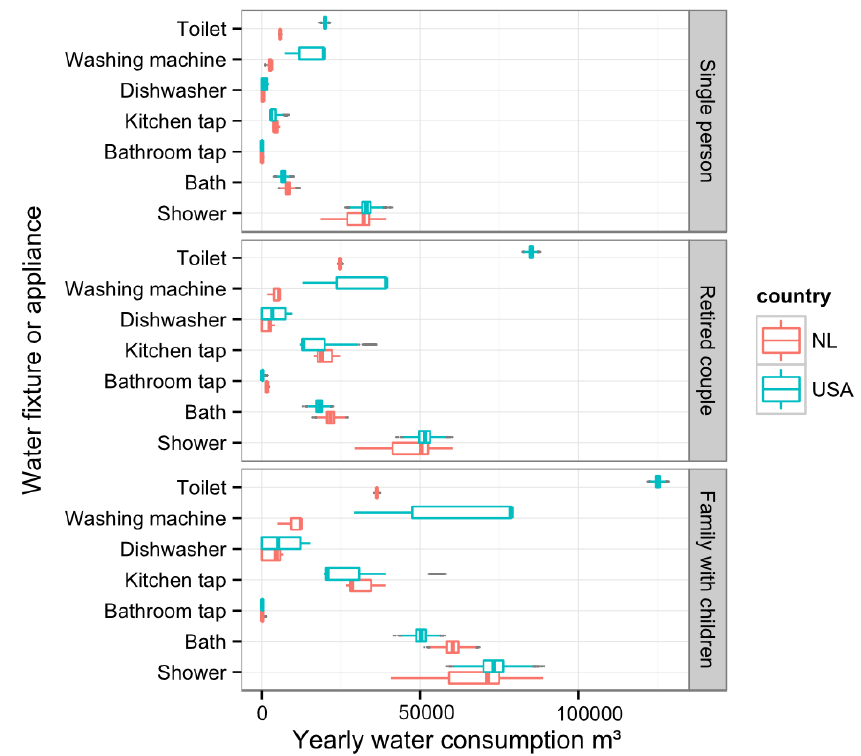
Figure 6. Distribution of total water usage in m 3 per year per water fixture and per household type.